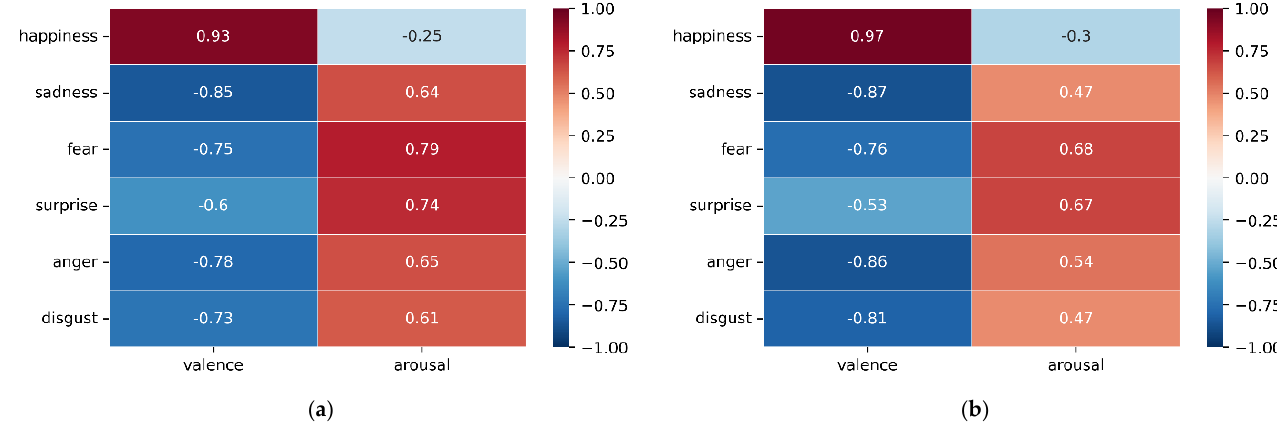
Figure 7. Correlations among 6 emotion norms (happiness, fear, sadness, surprise, anger, disgust) and 2 emotion dimensions (valence, arousal) in the NAPS BE dataset: ( a ) Pearson correlation coefficient matrix ( r ); ( b ) Spearman’s rank matrix ( r s ).